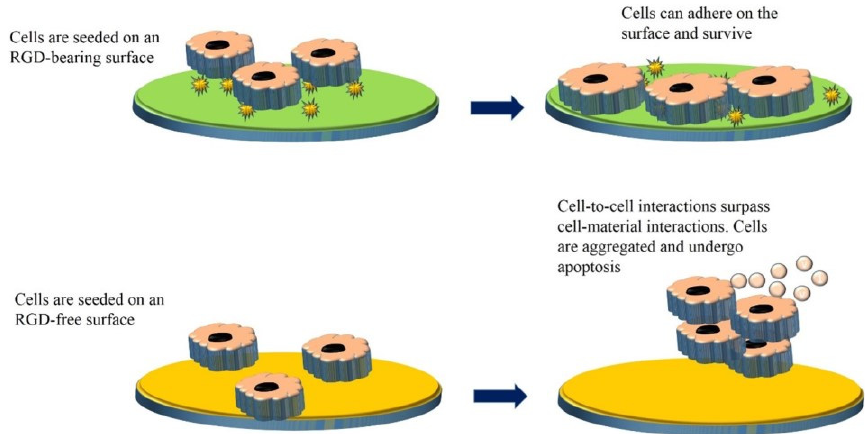
Figure 3. Schematic illustration representing the interaction of cells with RGD-free and RGD-incorporated surfaces.